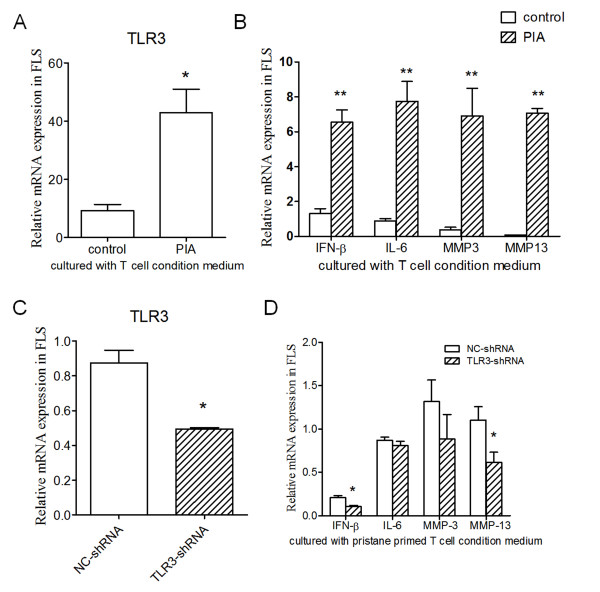
Activation of FLSs via TLR3 induction stimulated by pristane-primed, T-cell-conditioned medium. Rat FLSs were incubated with pristane-primed T-cell- or control T-cell-conditioned medium for 24 hours, and (A) TLR3 and (B) functional gene expression in FLSs were determined by using real-time PCR. Then rat FLSs were transfected with TLR3-shRNA plasmid and a negative control. (C) TLR3 mRNA expression was detected 24 hours after transfection. (D) TLR3-shRNA plasmid- and NC-shRNA plasmid-transfected FLSs were incubated with pristane-primed T cell condition medium, and the IFN-β, IL-6, MMP3 and MMP13 expression was detected at 24 hours. Data are presented as means ± SEM from three independent experiments. Levels of significance were calculated by using Student's t-test (*P < 0.05, **P < 0.01).